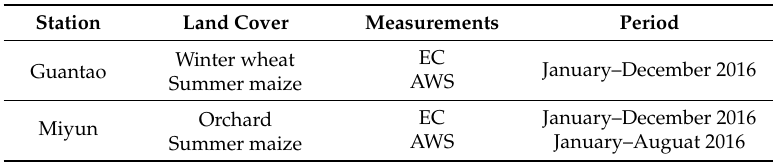
Table 1. Information from collected ground